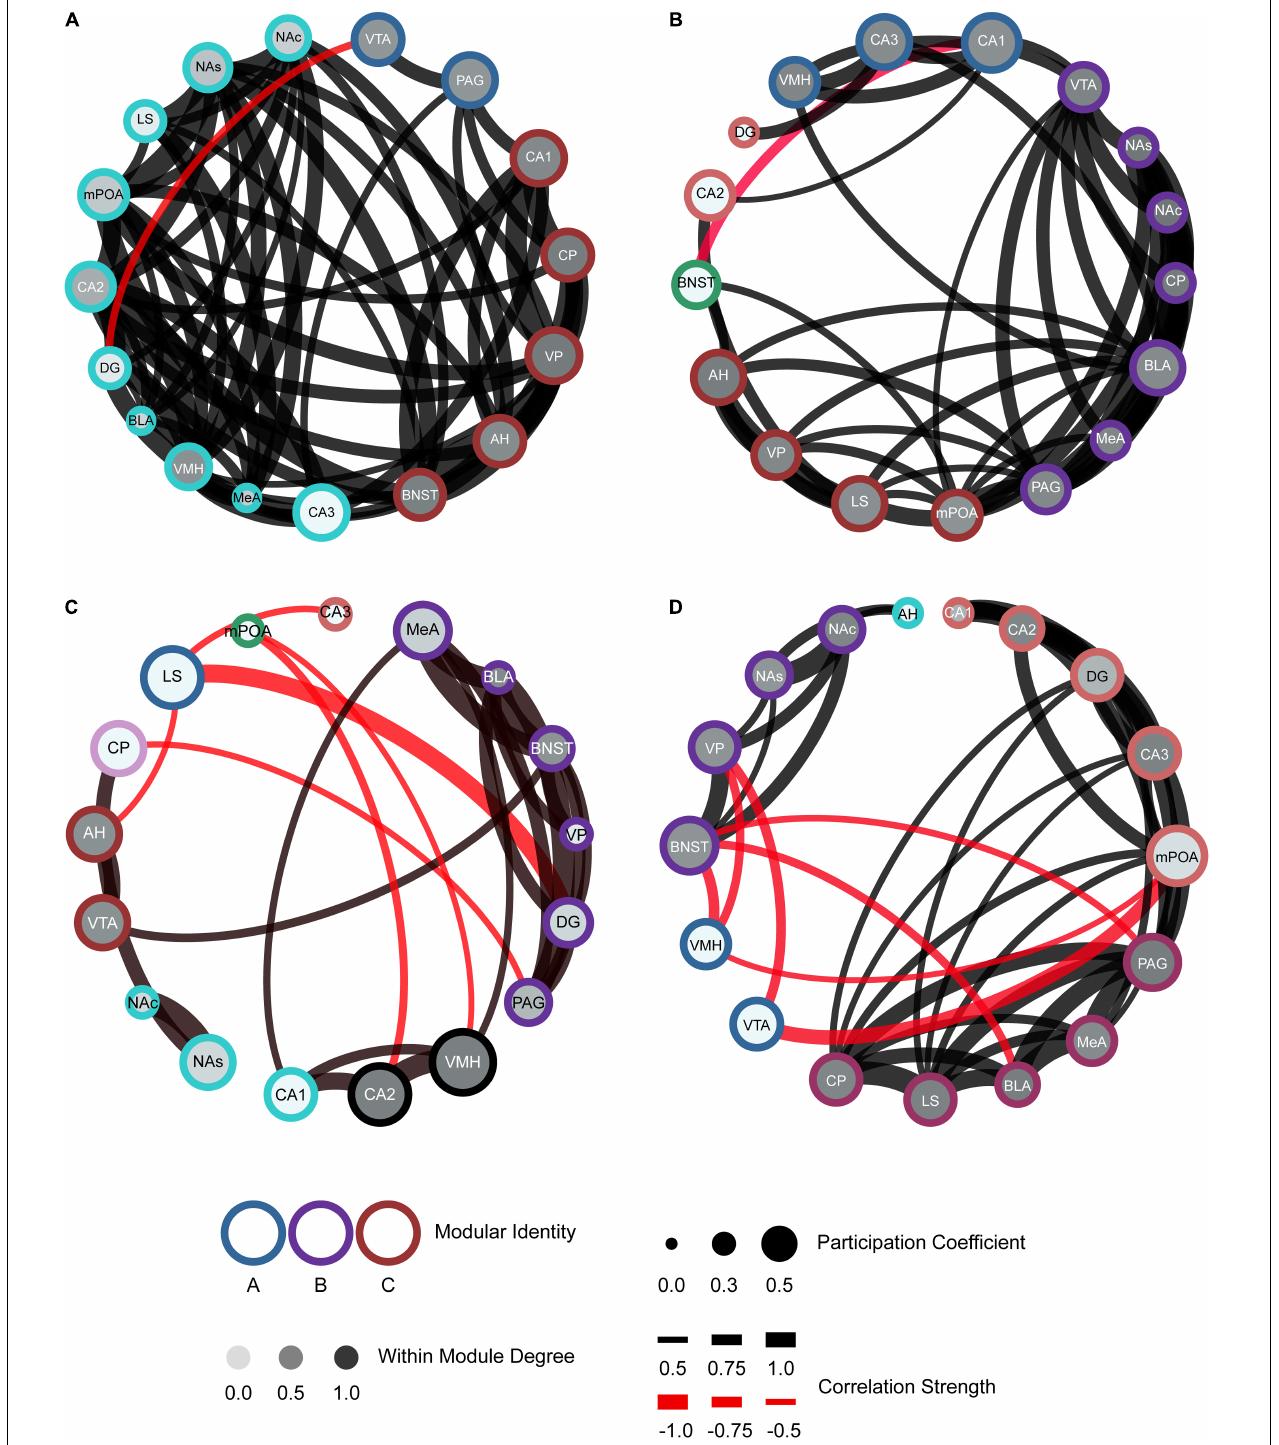
FIGURE 6 | Functional connectivity mapping for each social exposure: control (A) , partner (B) , opposite-sex stranger (C) , and same-sex stranger (D) . Nodes/brain regions for each network are represented by circles. The outer color of each circle represents modular identity. The shade of the internal color for each circle represents the within-module degree score (white = lowest score; black = highest score). The size of each circle represents the participation coefficient (smaller = Lower participation coefficient, larger = higher participation coefficient). The thickness of each line between nodes represents the strength of the correlation between regions (thin = lower correlation; thick = higher correlation). Positive (black) and negative (red) lines are represented between nodes based off the correlation matrices.